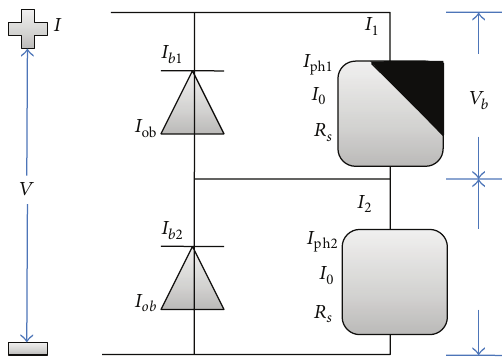
Figure 1: Equivalent circuit of a PV module with partial shading.